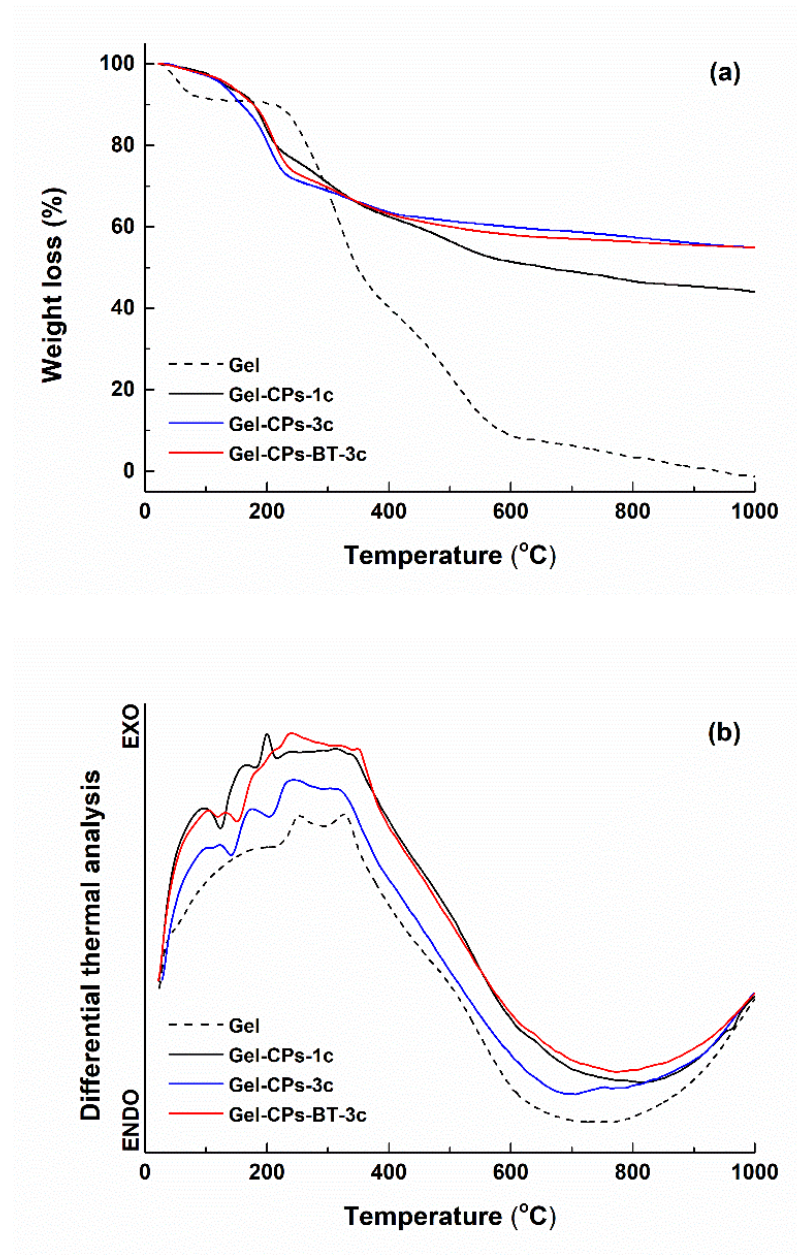
Figure 2. Complex thermal analyses of the template and as-prepared composites: ( a ) weight loss and ( b ) differential thermal analysis.